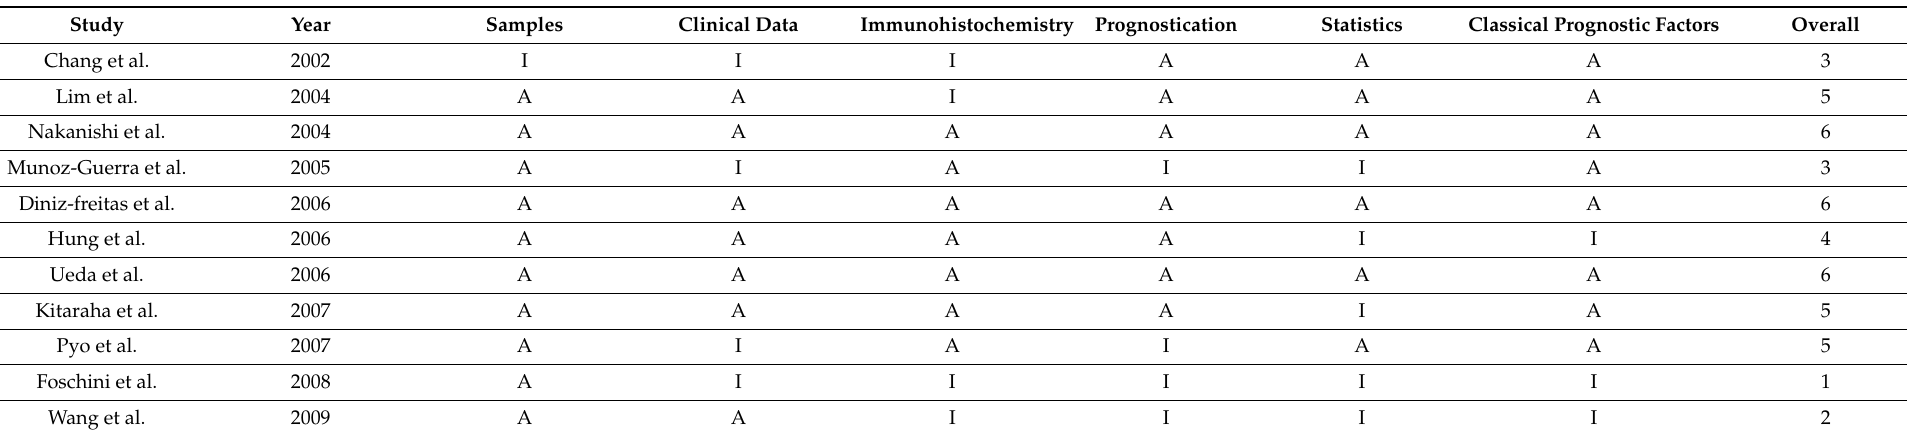
Table 3. Risk of bias assessment of included studies based on REMARK evaluation